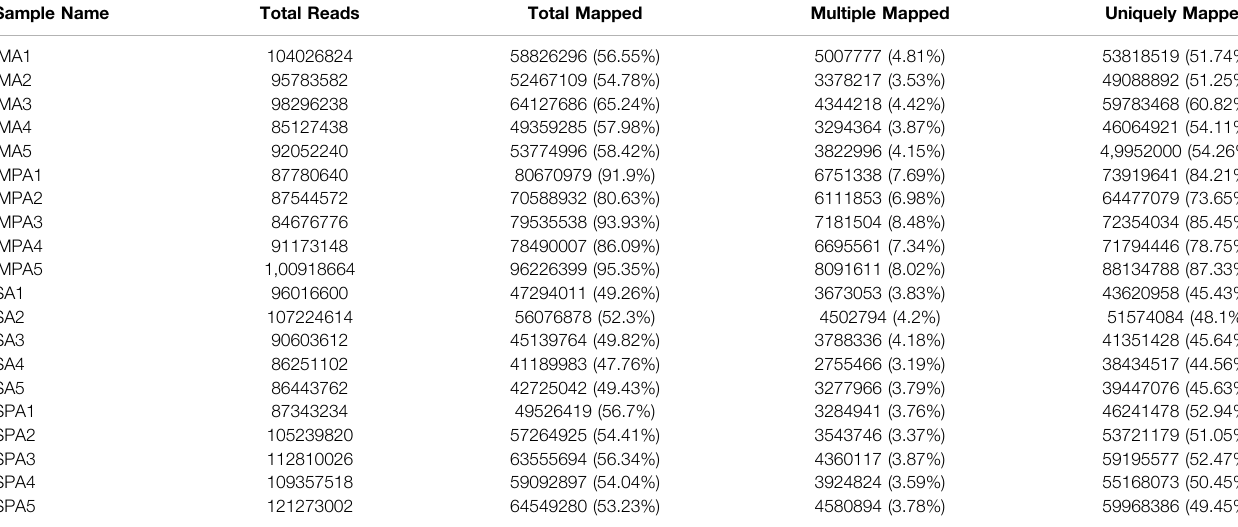
TABLE 3 | Summary of the clean reads alignment to the goat reference